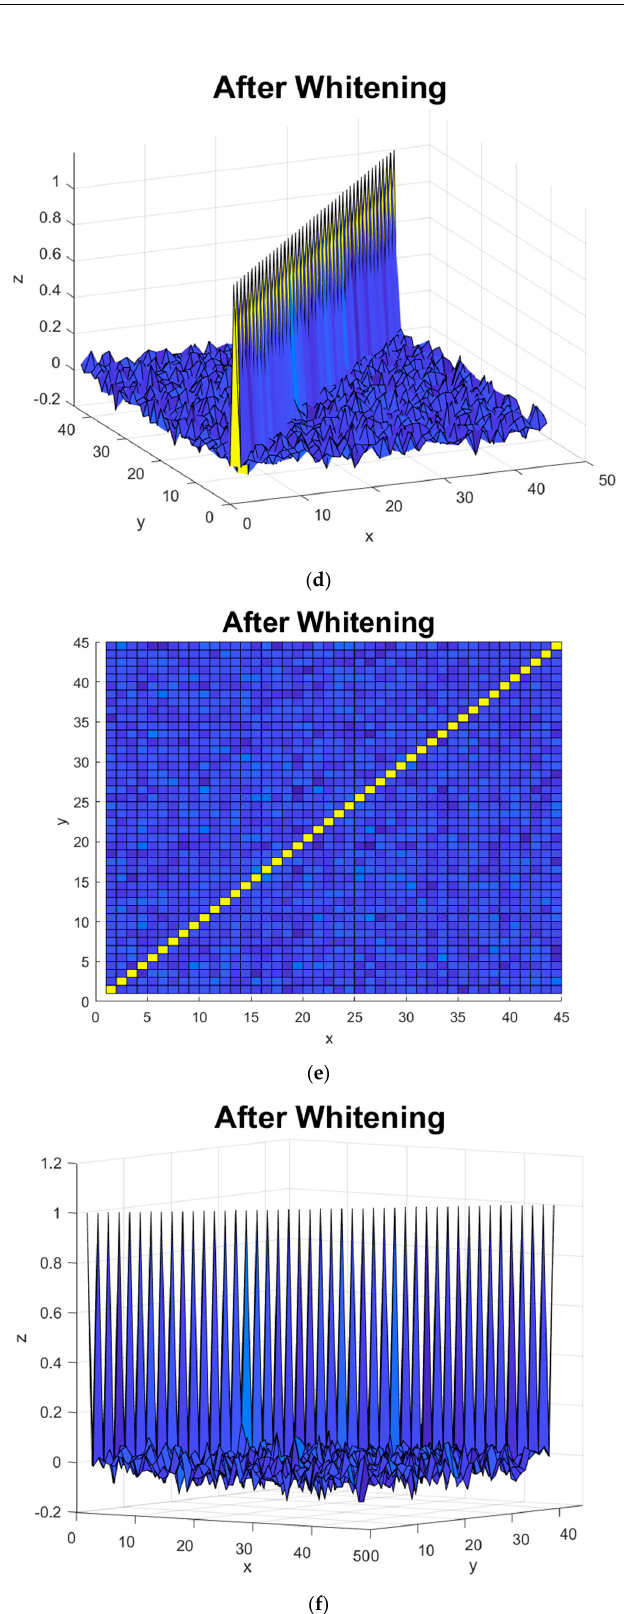
Figure 6. ( a , b ) Covariance matrix variances of C3D3a_2C for the first subject without BCICW method; ( c ) enlarged figure of ( a , b ); ( d , e ) covariance matrix variances of C3D3a_2C without whitening method; ( f ) enlarged figure of ( d , e